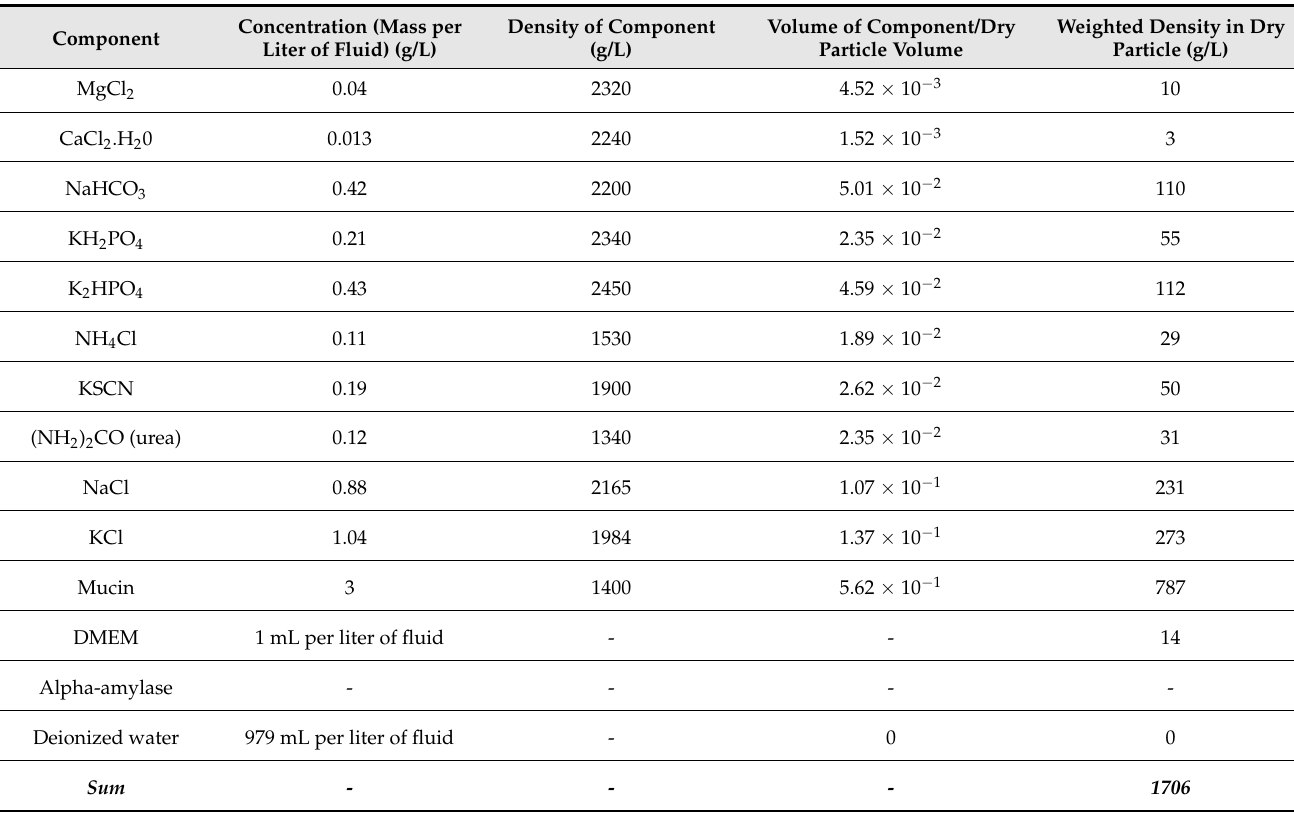
Table A1. Components of a saliva particle. The first two columns were calculated in [48] and the other columns were calculated.